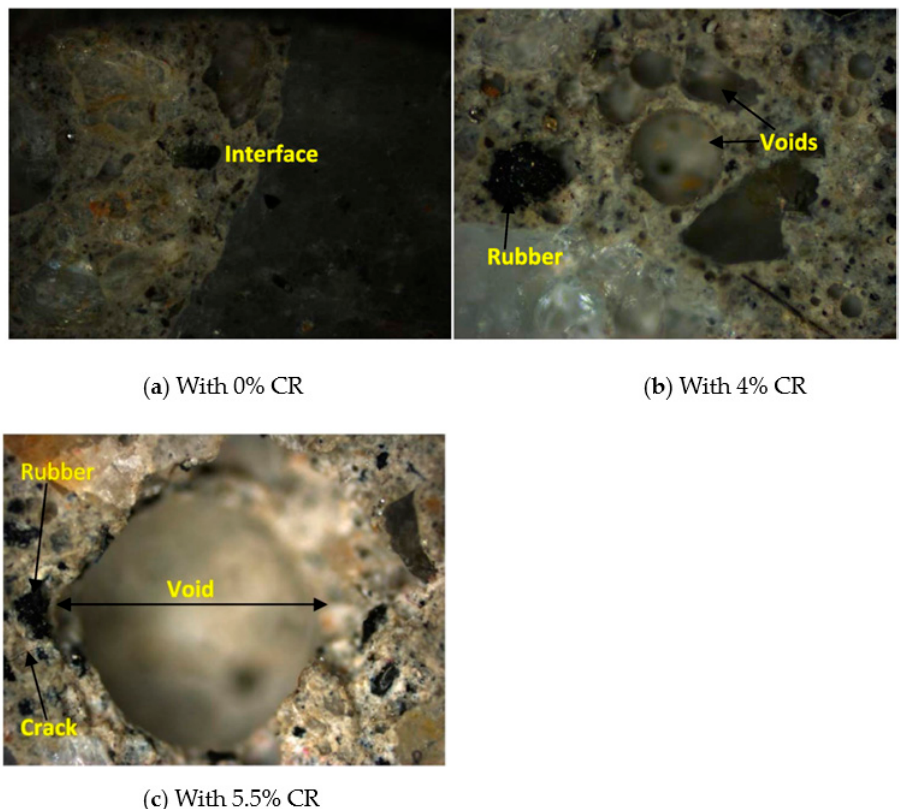
Figure 5. Optical microscope of CR concrete [54]. Table 6. Influence of rubber on the concrete water absorption.